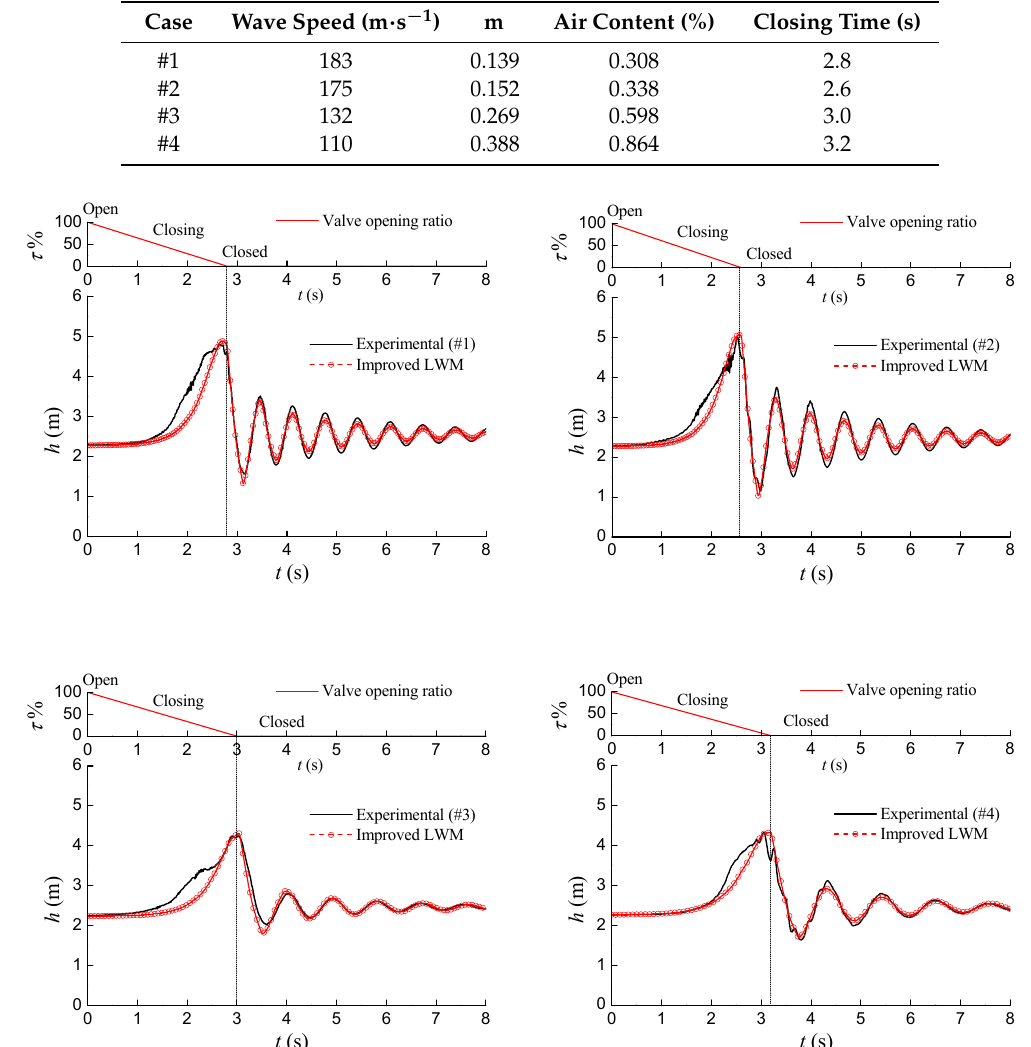
Table 2. Various valve closing speed simulations for validation.